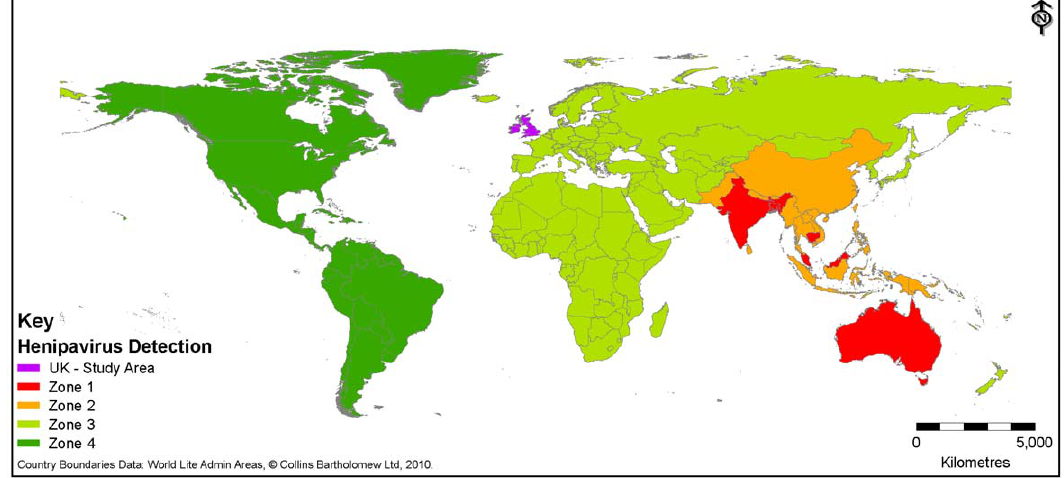
Figure 3. Identification of risk zones for henipavirus. Zone 1: countries with outbreaks of henipaviruses or where henipaviruses have been isolated from fruit bats. Zone 2: country that borders a Zone 1 country and Pteropus fruit bats are distributed in the country. Zone 3 indicates all other countries in Eurasia, and Africa and Australasia, which includes countries that have detected antibodies to henipaviruses in fruit bats. Zone 4: North and South America, which share no bat species with the ‘‘Old World’’ and no henipaviruses have been isolated or antibodies detected.